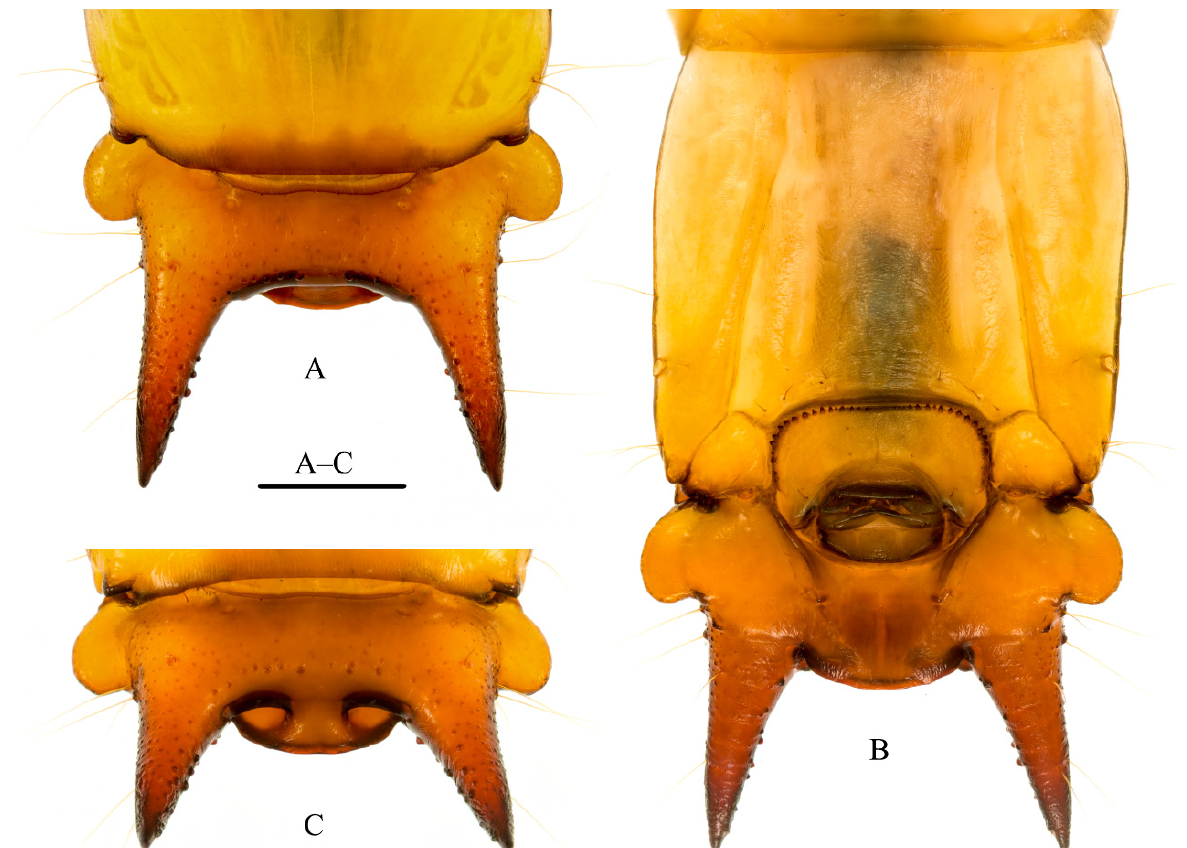
Figure 5. Larva of Pseudopyrochroa reni Pan & Young, n. sp. ( A ) Urogomphal plate and urogomphi, dorsal view; ( B ) Sternite VIII–X, urogomphal plate, and urogomphi, ventral view; ( C ) urogomphal pits and urogomphal lip, posterior view. Scale bar: 1 mm.